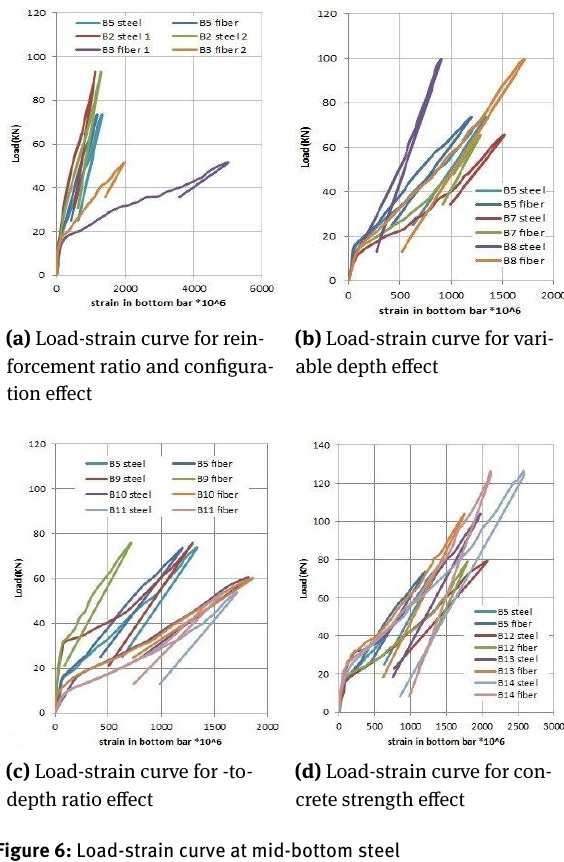
hybrid GFRP/steel, were 64.5kN, 17.5 kN, and 37.4 kN